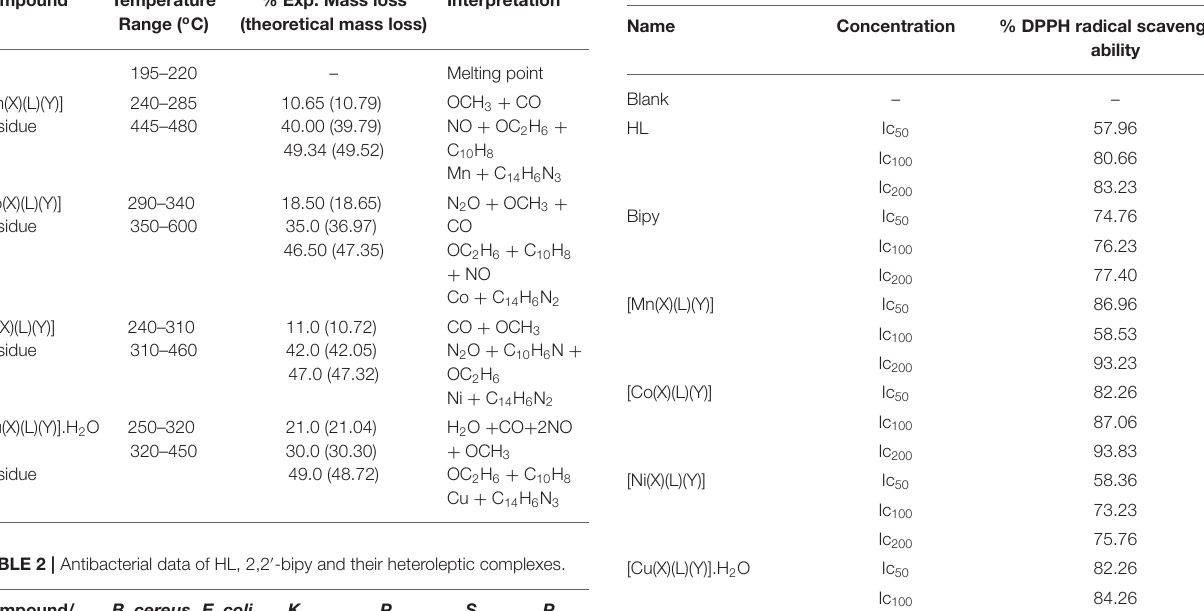
TABLE 4 | Antioxidant data of HL, 2,2 ′ -bipy and their heteroleptic complexes.